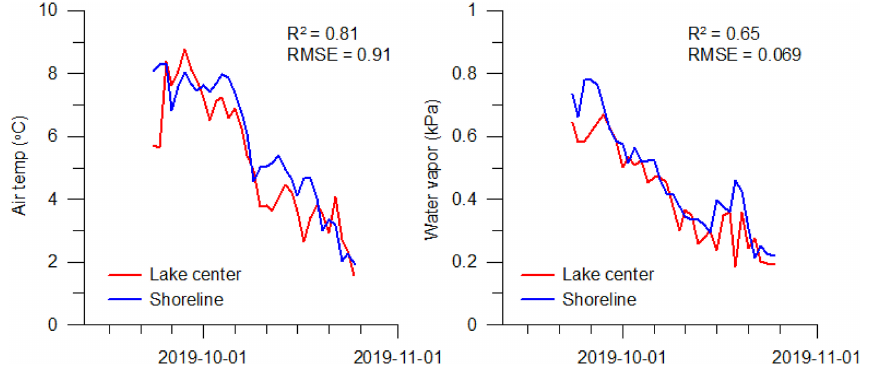
Figure 9. Comparison of daily air temperature and water vapor pressure between the shoreline and the lake center during the period of 23 September–25 October 2019. Table 3. Runoff (m 3 s − 1 ) of the three main rivers in Paiku Co basin during the pre-monsoon and post-monsoon seasons between 2015 and 2017 and their total contribution to lake-level increase (mmd − 1